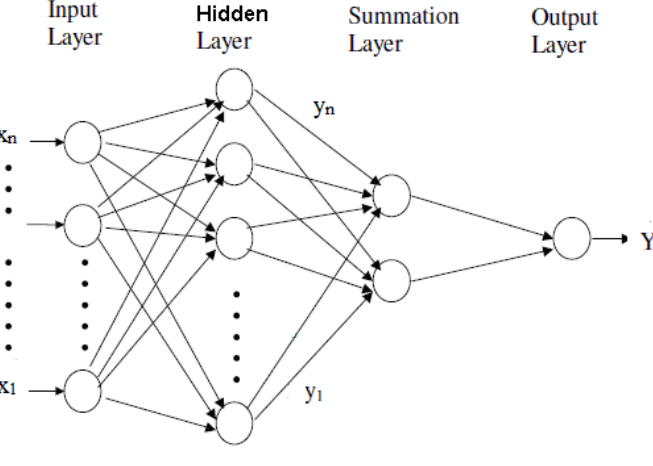
Figure 3. GRNN diagram.